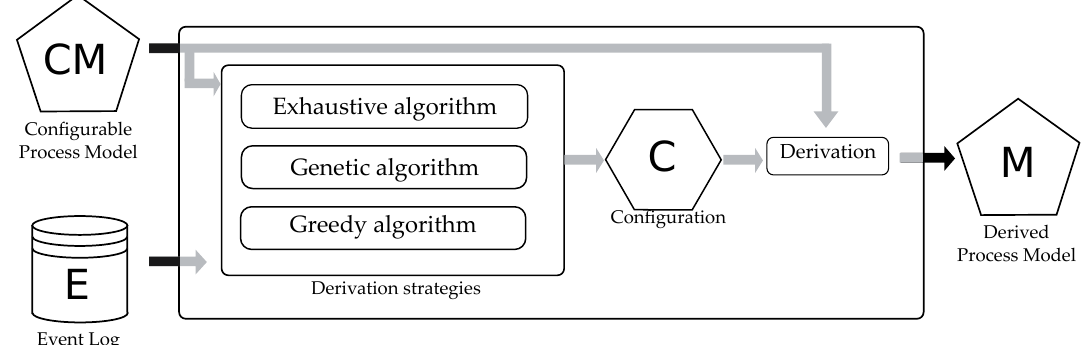
Figure 2. Overview of the proposed framework to derive a process model. Three alternative derivation strategies allow obtaining a configuration that later on is used to derive a process model from the configurable process